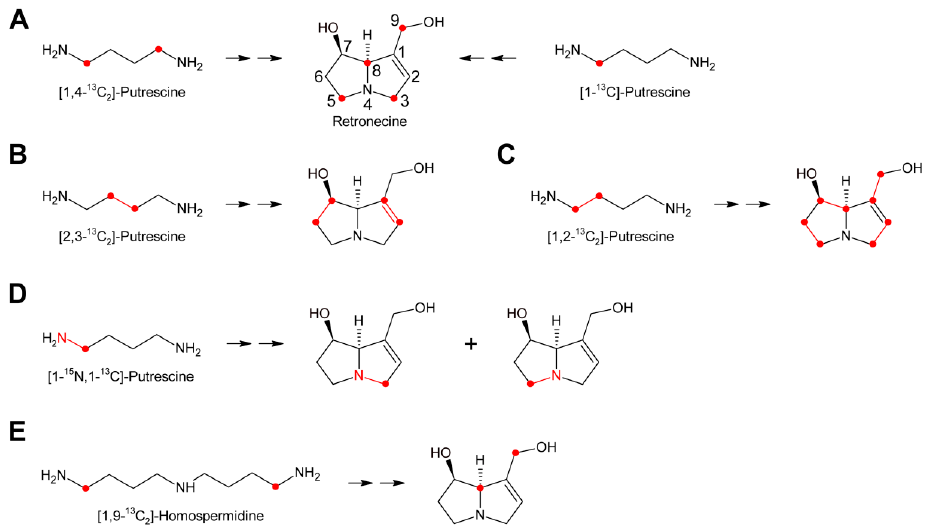
Figure 7. Investigation of necine base biosynthesis by feeding of stable isotope labeled precursors. Feeding of ( A ) [1,4- 13 C 2 ]-putrescine and [1- 13 C]-putrescine, ( B ) [2,3- 13 C 2 ]-putrescine, ( C ) [1,2- 13 C 2 ]-putrescine, ( D ) [1- 15 N, 1- 13 C]-putrescine and ( E ) [1,9- 13 C 2 ]-homospermidine. Red dots symbolize 13 C labels, a red N symbolizes a 15 N label. 13 C- 13 C double labels are marked with bonds in red. Please mind that the retronecine structures shown in (A), (B), and (C) are composite representations of all labeled species present.